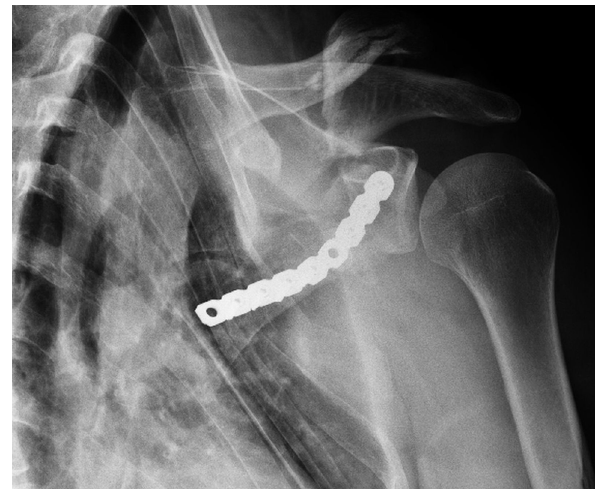
Figure 8: Post - surgery X -